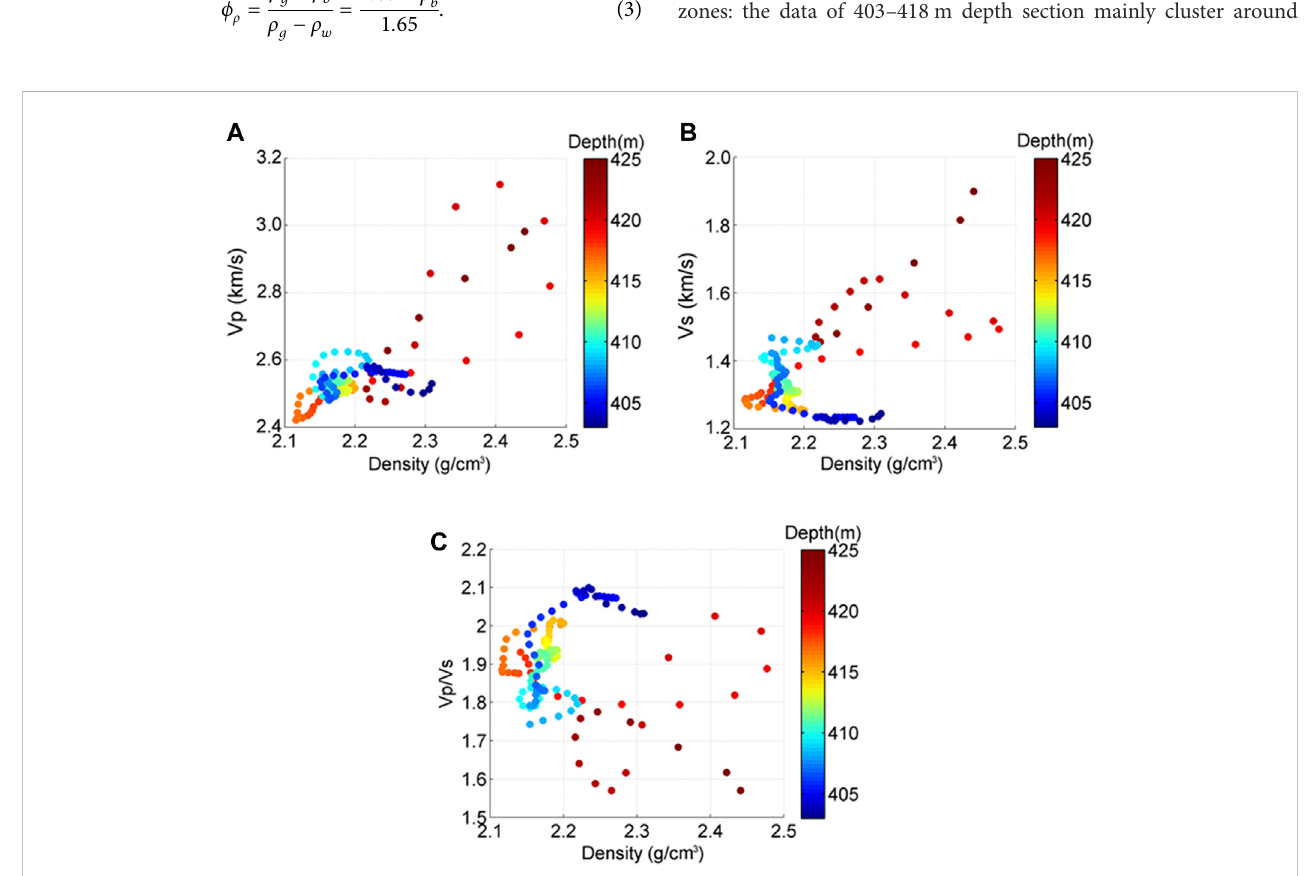
FIGURE 4 Cross-plot of density, depth, and (A) Vp, (B) Vs, and (C) Vp/Vs ratio.